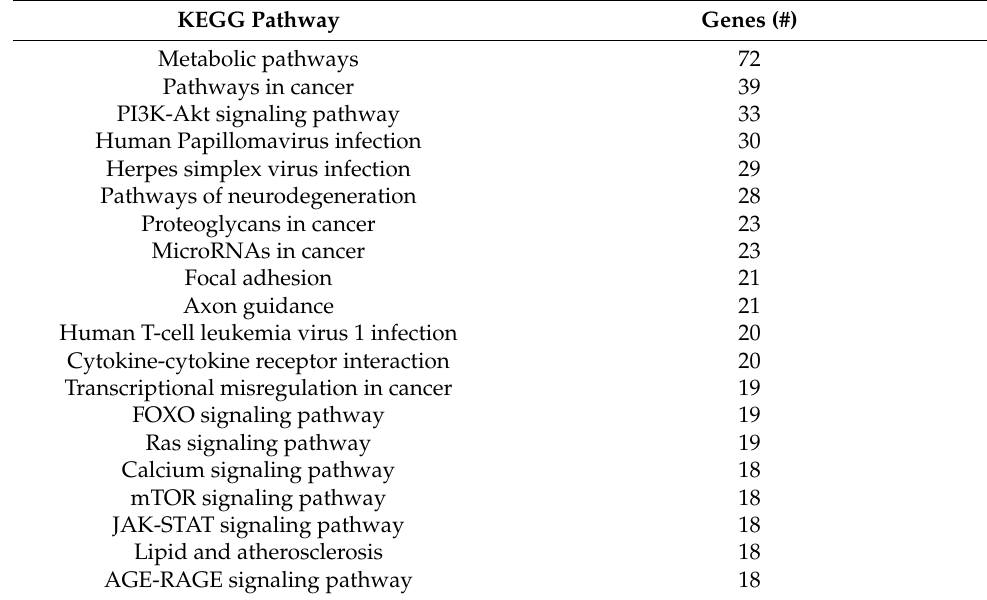
Figure 4. Physiologic pathways targeted by the five milk miRNAs implicated in low milk supply. The heatmap displays the relative level of messenger RNA targets for 13 Kyoto Encyclopedia of Genes and Genomes (KEGG) pathways, where red represents the highest number of targets. These 13 pathways all displayed a significantly greater number of targets than would be expected by chance alone on Fisher Exact Testing. Note that pathways and miRNAs have been clustered using the Ward method, and the dendrograms display relatedness of each pathway or miRNA. Table 4. Top twenty physiologic pathways targeted by